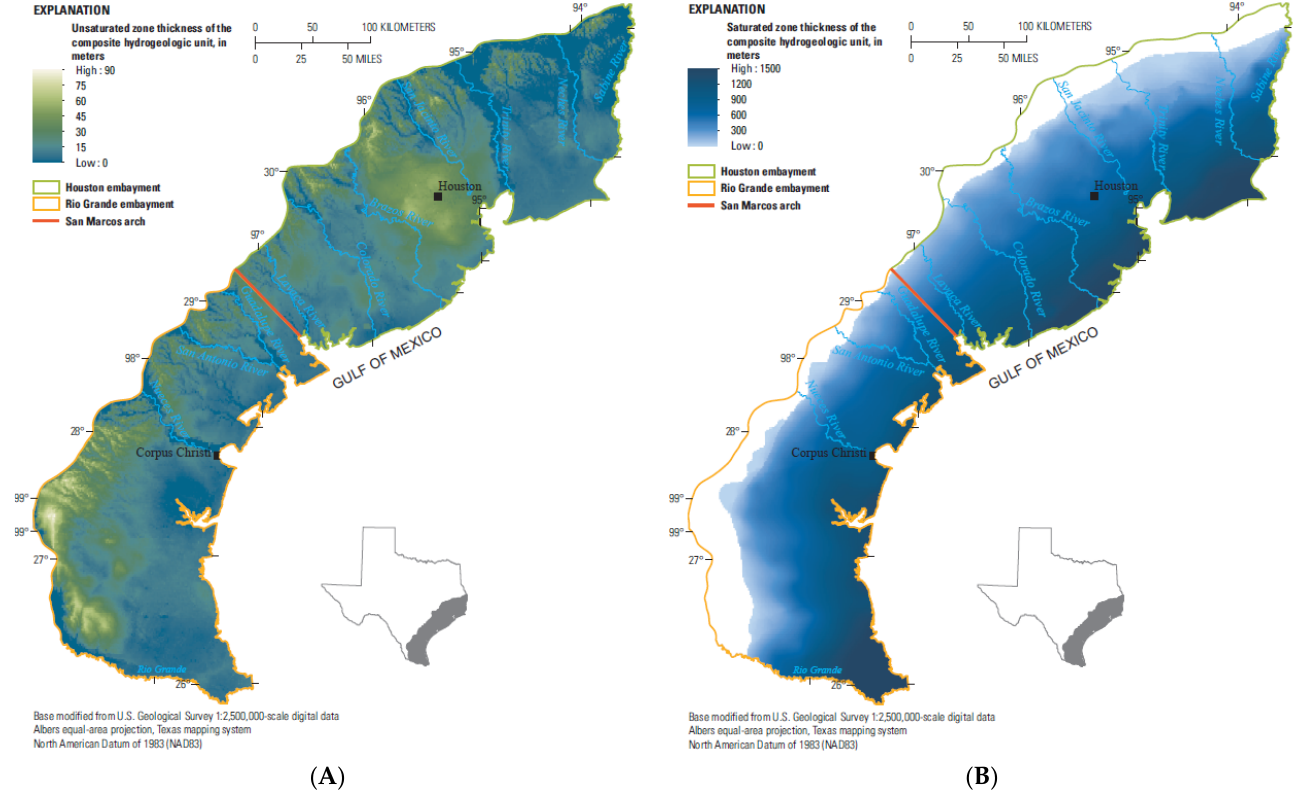
Figure 11. ( A ) Unsaturated and ( B ) saturated zone thickness of the composite hydrogeologic unit based on recent (2007–2016) water-level altitudes within permissive tract 3 within the Texas Coastal Plain.